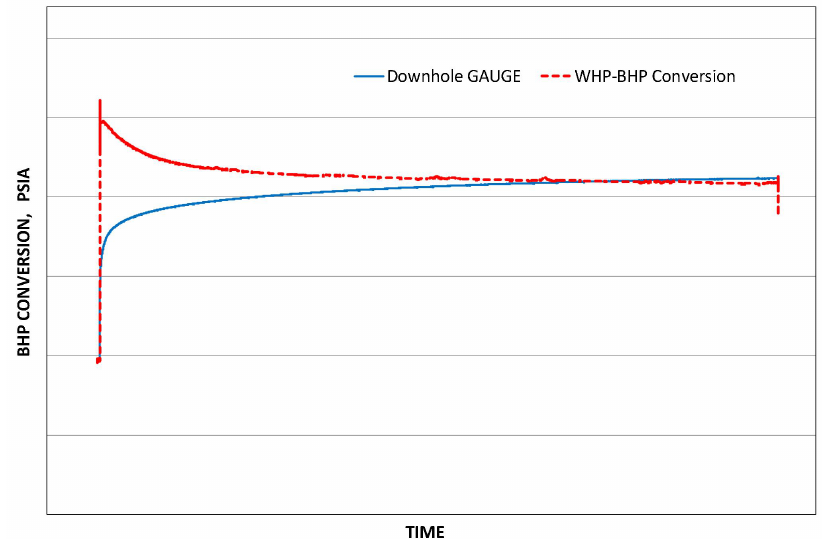
Figure 5—“Conflicting” surface and downhole pressures.